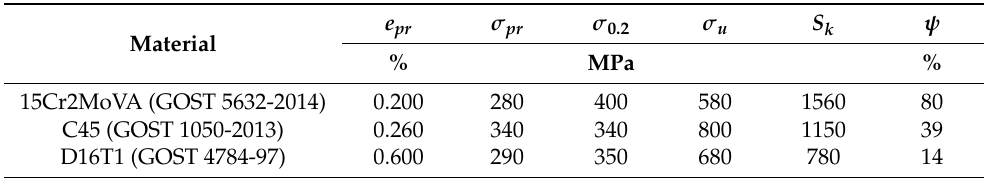
Table 2. Mechanical properties of the materials.